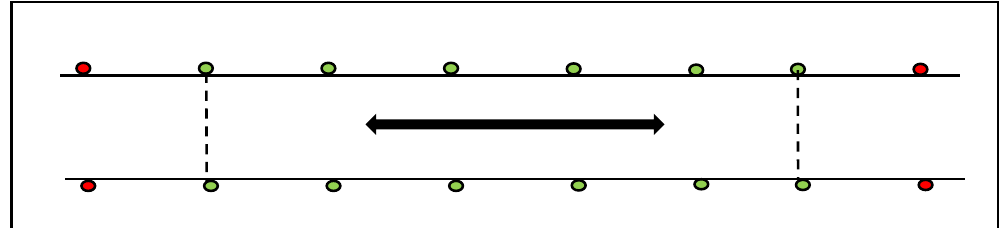
Figure 3. Diagram illustrating the experimental track. The experimental track represented by the green markers and the start and end points being represented by the red markers. The experimental track allowed 11 straight strides in sitting trot and 15 strides in canter to be captured, with both the start and end points being determined by two red cones.